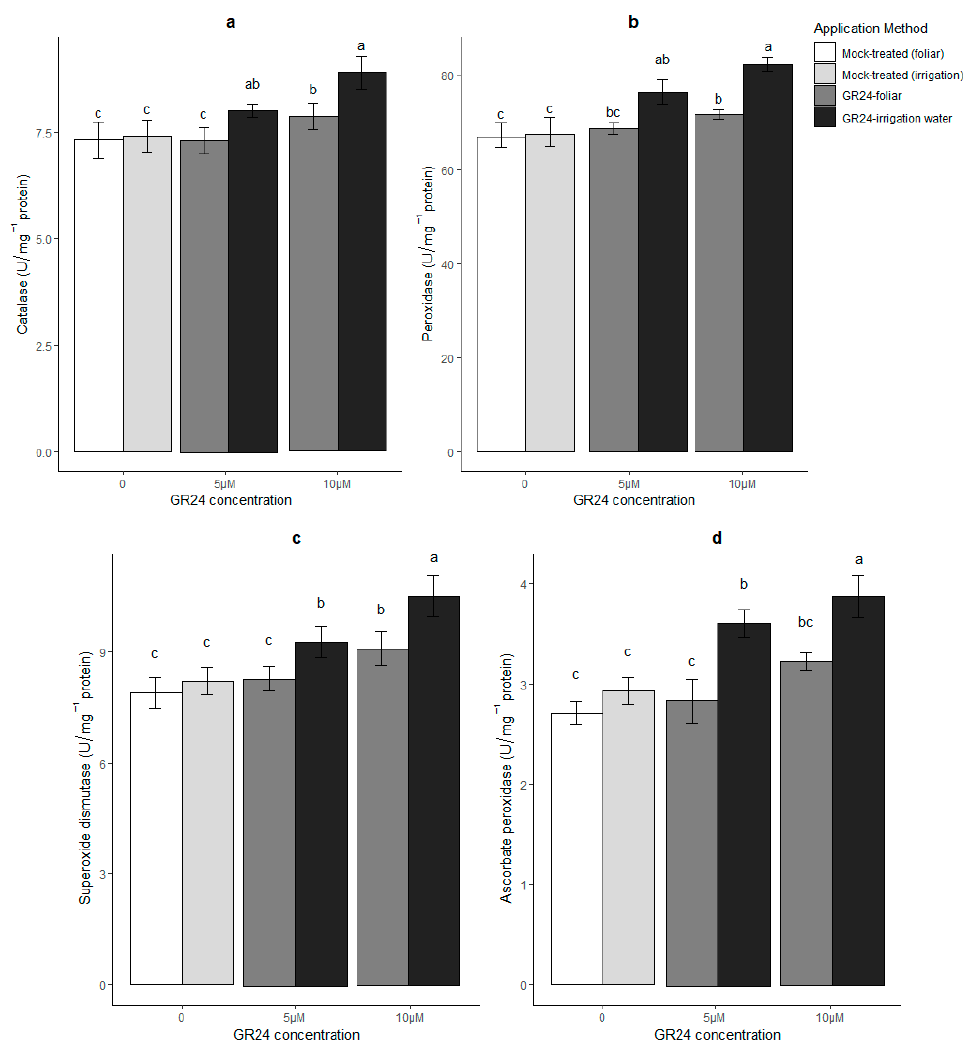
Figure 4. Catalase ( a ), peroxidase ( b ), superoxide dismutase ( c ) and ascorbate peroxidase ( d ) enzyme activities in wheat leaves under drought stress conditions, in response to two application methods for GR24. Mock-treated plants in these graphs were equally drought-stressed but received a water and acetone solution; for irrigated control values; see Supple- mentary Materials Figure S5. Each value represents the mean ± SE ( n = 4, each replicate the pool of four plants). Different letters on top of bars indicate significantly different means for p ≤ 0.05 (LSD test).